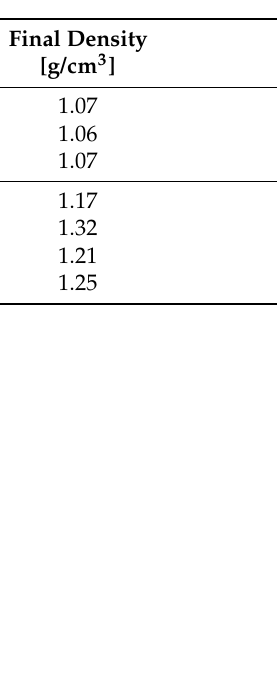
Table 4. Influence of the use of a mould in the density increase.